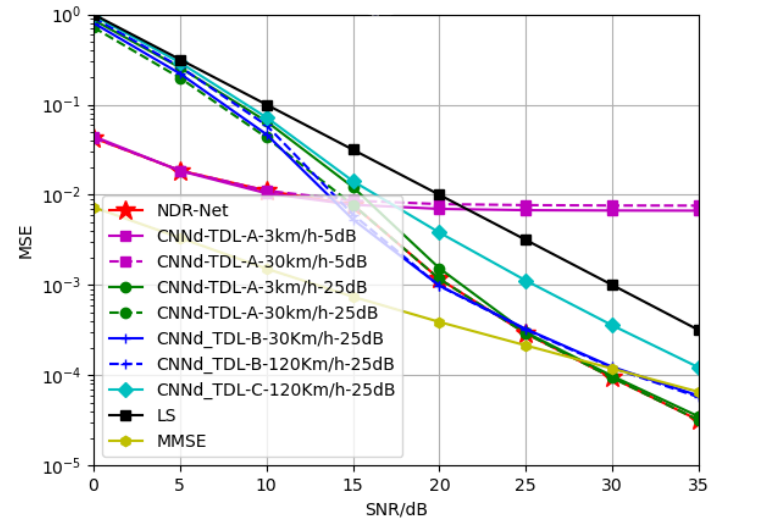
Figure 12. Generalization performance of different channel estimators when the test channel is TDL-A, SNR = 15 dB, Velocity = 30 Km/h.